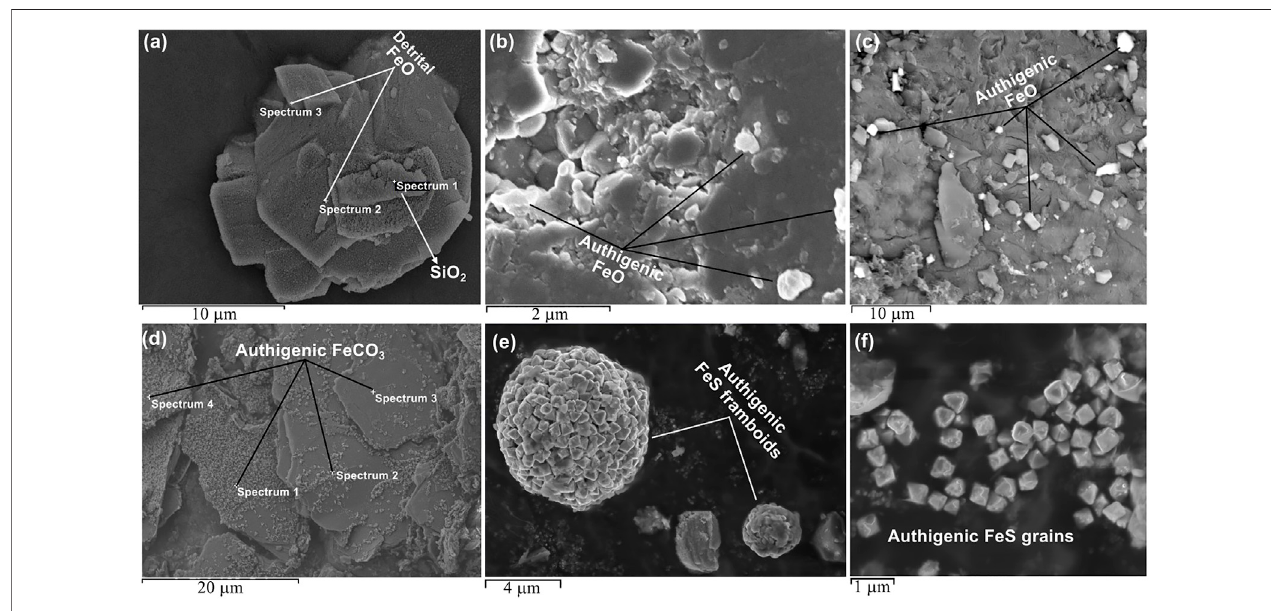
FIGURE11| MicroscopiccharacterizationofmagneticmineralsinmagneticextractsfromdifferentsamplegroupsincludingcorrespondingpointsofEDXanalysisif carried out: (A) an iron-oxide crystal likely detrital identi fi ed in a reservoir sandstone sample, (B) Fine grain iron-oxide crystals in a sample from the oil leg, (C) backscattered electron image showing contrast between the iron-oxides minerals and the iron-poor background, (D) through EDX analysis, the platy structures that dominatestheextractfromanoillegsamplewithhighparamagneticresponsesarecon fi rmedtobesideritecements, (E) Ironsulphideframboidsobtainedfromthe CAD sediments, and (F) Authigenic iron sulphide grains from the CAD